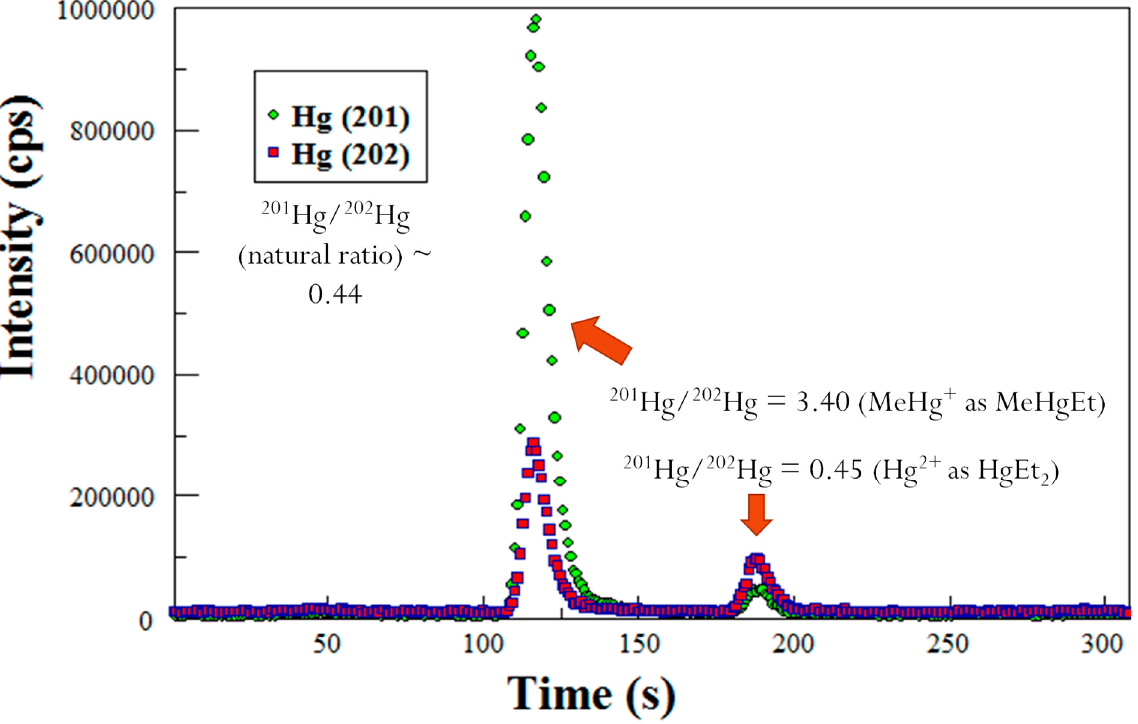
Figure 5. GC-ICP-MS chromatogram showing isotope ratios for Hg species: Hg +2 with natural abundance (peak ~ 185 s) and an enriched isotope 201 MeHg spike (peak ~ 115 s).